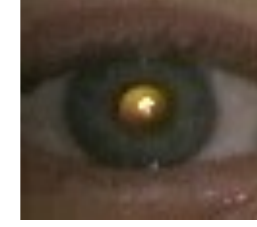
Figure 3. An example key frame cropped around the pupils for each